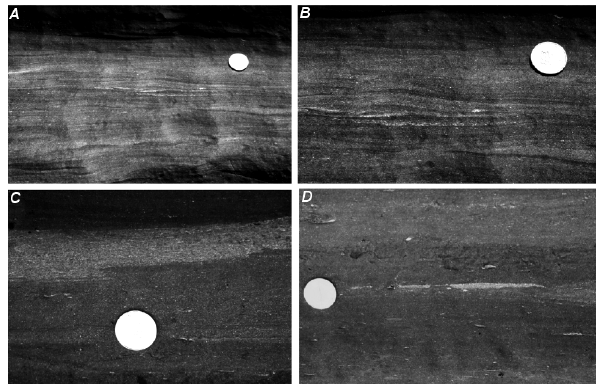
Figure 7. Low angle truncations and small scale erosional surfaces indicating sediment reworking and re-distribution through small scale erosion and/or winnowing by bottom currents. (a) and (b) Coastal section near Shell–Onhym oil shale mine, lower Turonian; (c) and (d) Amma Fatma coastal section, base of Turonian. Scale: one dirham coin (24mmdiameter).